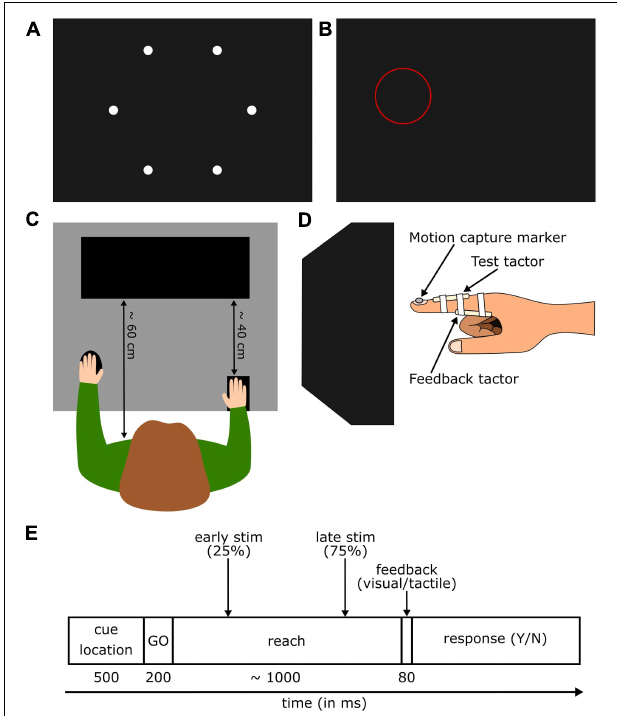
FIGURE 1 | (A) Display of all possible target locations on the screen. (B) Example for a location cue (red circle) presented at the beginning of each trial. The cue was positioned so that the target was always in its center. The target was never visible during the experiment. (C) Top view of the setup showing a participant sitting in front of the screen with the right hand on the start position and the left hand on the response buttons. (D) Side view of the right index finger hovering in front of the screen. (E) Time course of a trial in the detection block. After the presentation of the cue location and a go cue, participants reached to the target with their right hand. A short vibrotactile probing stimulus was presented either early or late during the movement. After finding the target and receiving the feedback, participants indicated whether they felt the probing stimulus or